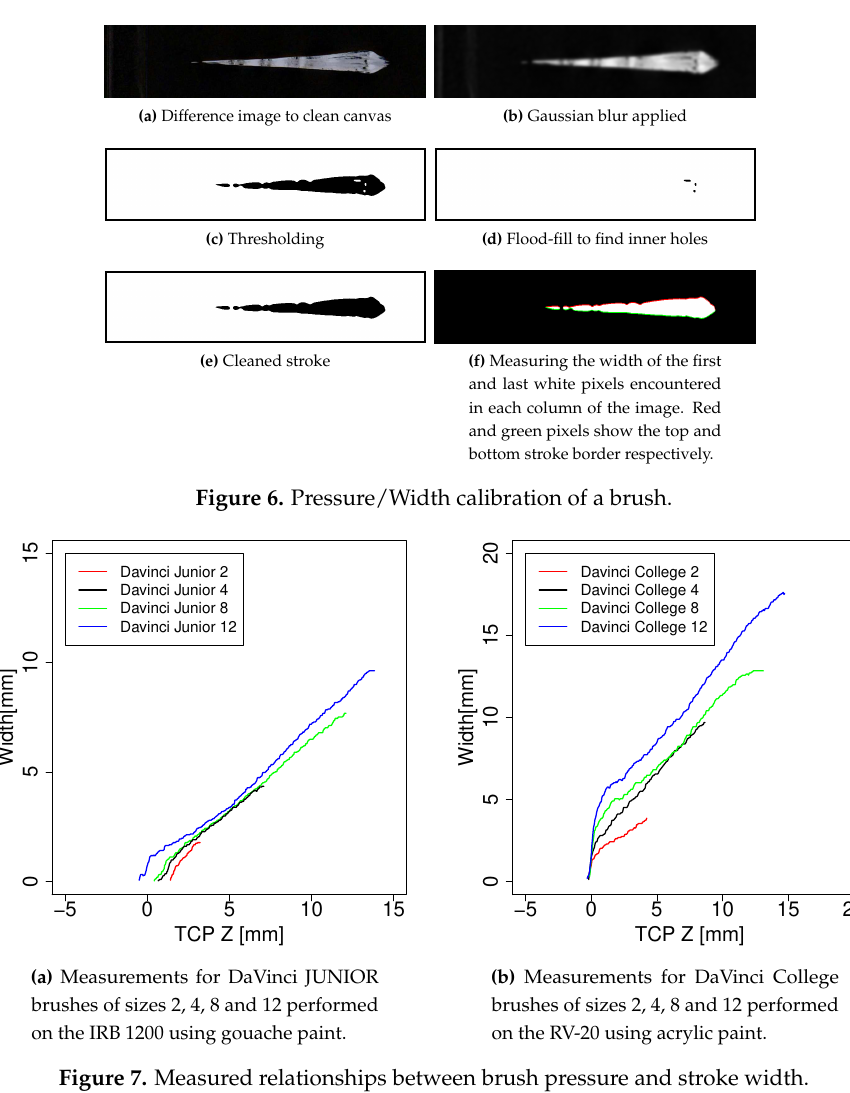
Figure 7. Measured relationships between brush pressure and stroke width.